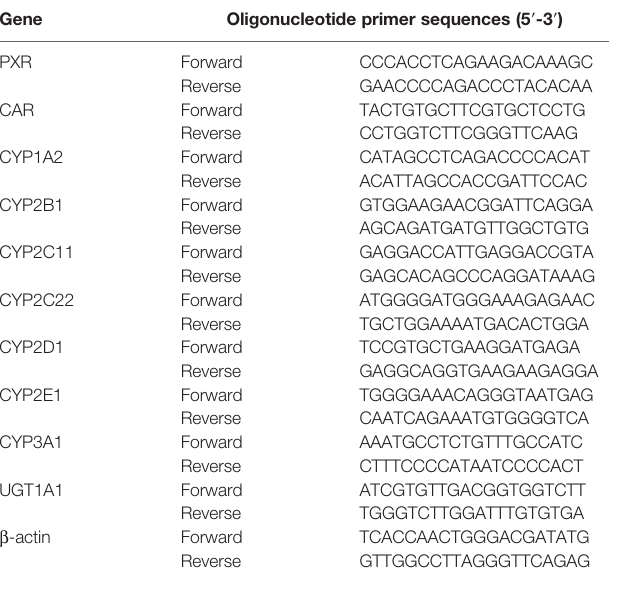
TABLE 1 | Rat primers used for real-time PCR analysis.